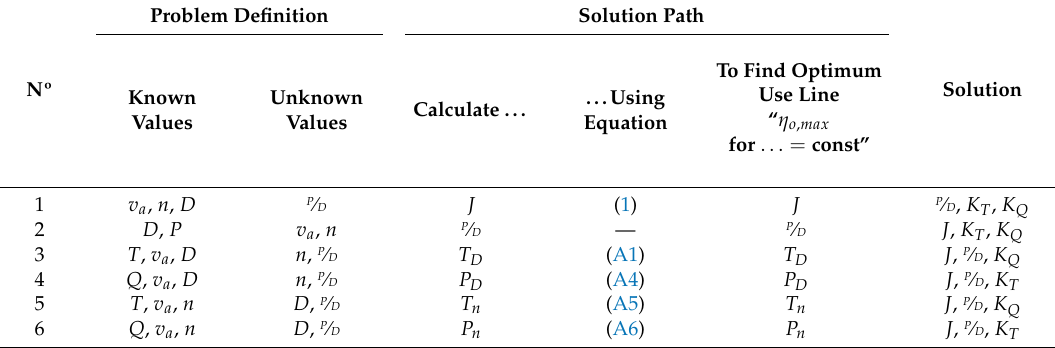
Table A2. The six basic optimisation problems encountered by propeller designers and their solution paths. All unknown values can finally be calculated from the